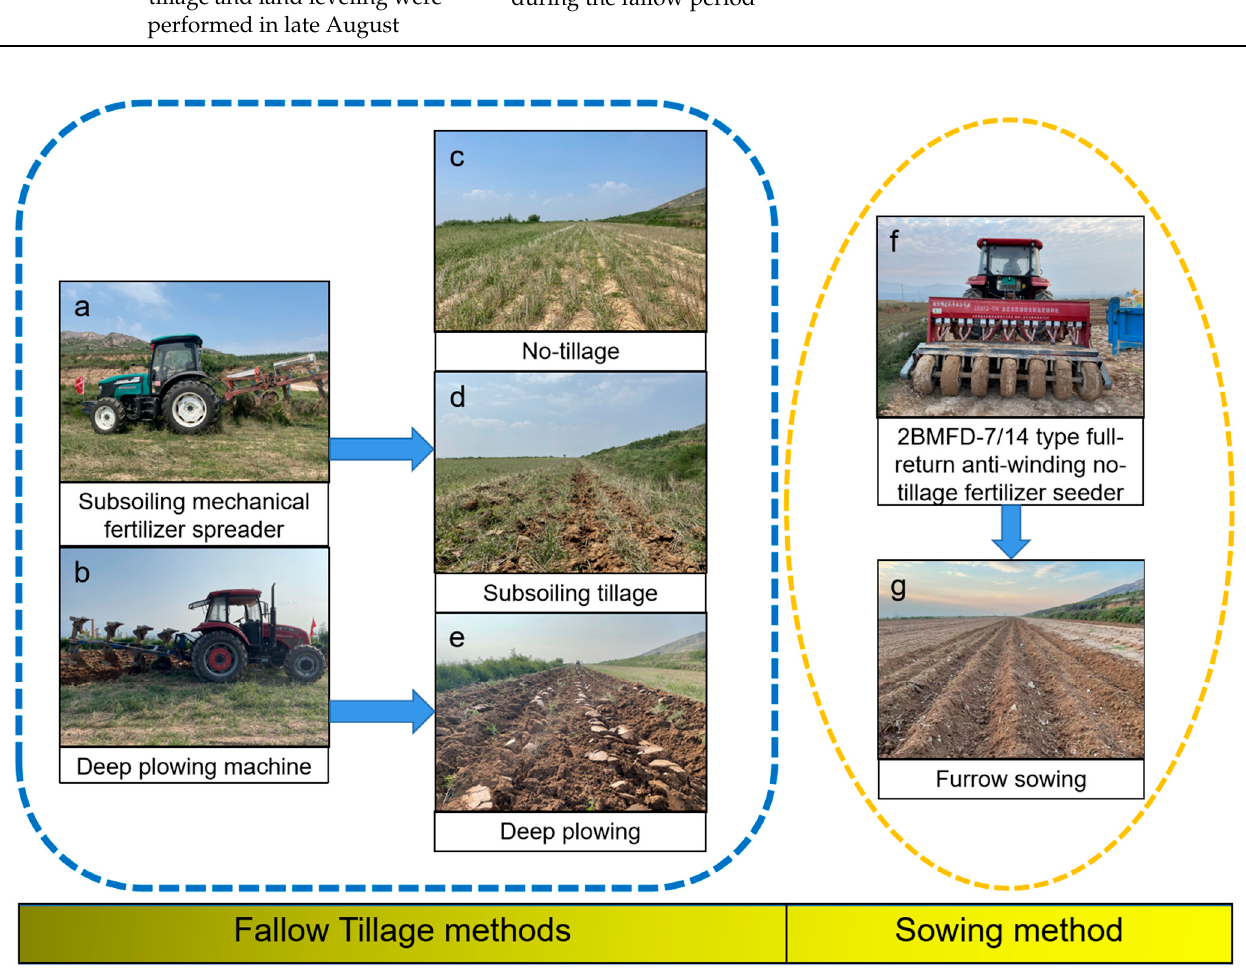
Figure 1. Two fallow tillage machines ( a , b ), three fallow tillage methods ( c – e ), sowing machine ( f ), and sowing method ( g ).